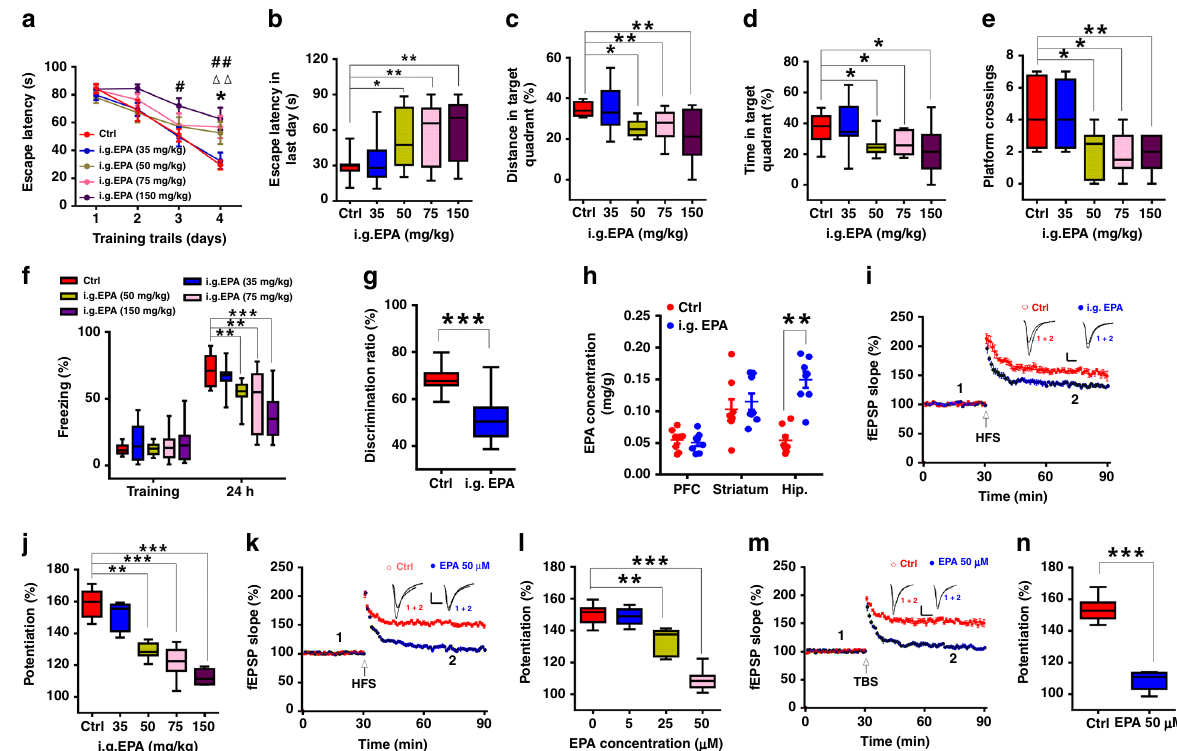
Fig. 1 EPA administration impaired learning and memory and hippocampal LTP in adult mice (P60). a , b Mean escape latencies across 4 consecutive days ( a ) or on the last day ( b ) during the MWM training ( n = 9 – 11 mice/group; a : repeated measures two-way ANOVA, F (4, 180) = 55.518, P < 0.0001; b : one-way ANOVA, F (4, 47) = 54.568, P = 0.003; asterisk, triangle or hash indicates differences between EPA [50], EPA [75] or EPA [150] and Ctrl [saline- treated], respectively). c , d Percentage of distance ( c ) or time ( d ) spent in target quadrant during the probe trials (one-way ANOVA; c : F (4, 47) = 43.806, P = 0.016; d : F = 43.381, P = 0.018). e Number of platform crossings during the probe trials (one-way ANOVA; F = 45.431, P = 0.002). f Freezing (4, 47) (4, 47) time in the contextual fear conditioning test ( n = 10 – 12 mice/group; one-way ANOVA; F (4, 50) = 48.636, P < 0.0001). g Discrimination ratio of time spent interacting with a novel object versus a familiar object in the NOR test (50mg/kg, n = 10 mice/group; two-tailed Student ’ s t -test; P < 0.0001). h I.g. administration of 50mg/kg EPA increased the EPA level in the hippocampus (detected at 1 h after EPA administration; n = 8; two-tailed Student ’ s t -test; P = 0.001). i , j I.g. administration of EPA suppressed HFS-induced LTP (recorded at 2h after EPA administration; n = 5 – 7 slices/group; one-way ANOVA; F (4, 26) = 52.545, P < 0.0001). k – n Acute EPA treatment 10min after establishing the baseline recording impaired HFS-LTP ( k , l , n = 5 – 14 slices/group; one-way ANOVA; F (3, 35) = 47.807, P < 0.0001) and TBS-LTP ( m , n , n = 7 – 8 slices/group; two-tailed Student ’ s t -test; P < 0.0001). Scale bars: 0.5mV, 5 ms. Data show mean ±s.e.m.. * P <0.05, ** P < 0.01, *** P <